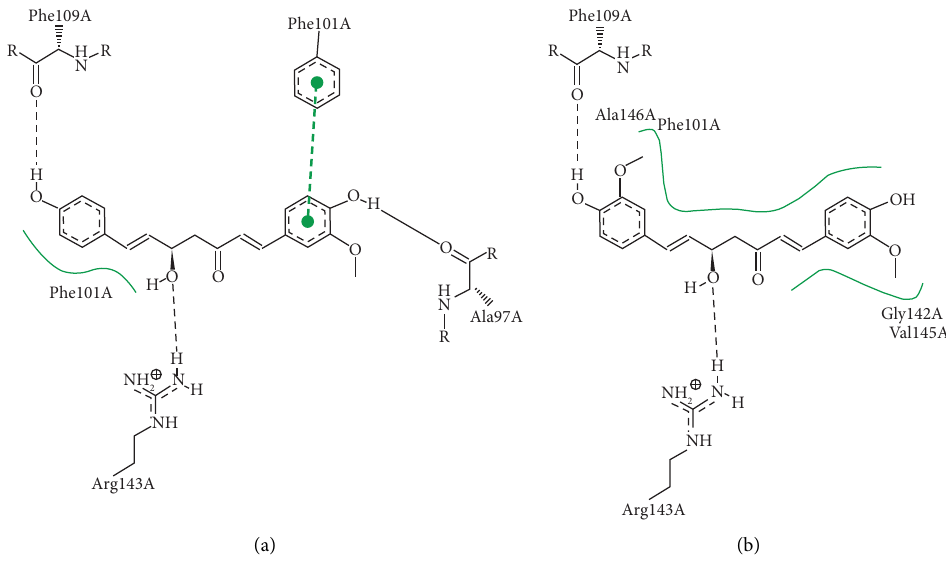
Figure 4: 2D interaction models in the active site of Bcl-2 protein and compounds 4 (a) and 5